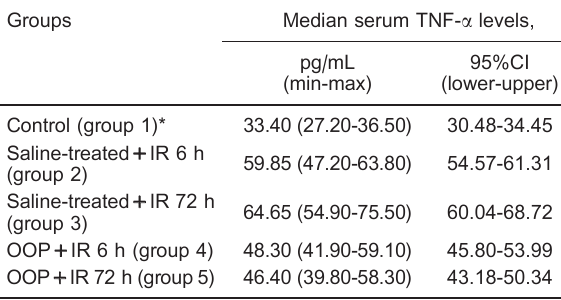
Table 1. Serum TNF- a levels of control, saline-treated++IR, or OOP++IR groups decapitated at 6 or 72 h after irradiation. Groups